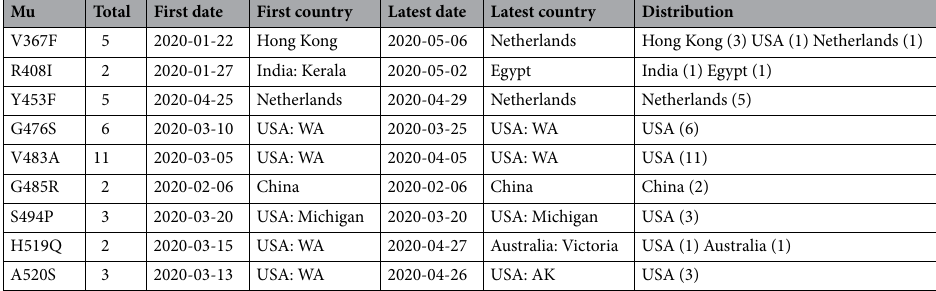
Table 11. Gene S—RBG region only—nonsynonymous mutations that occur in 2 or more